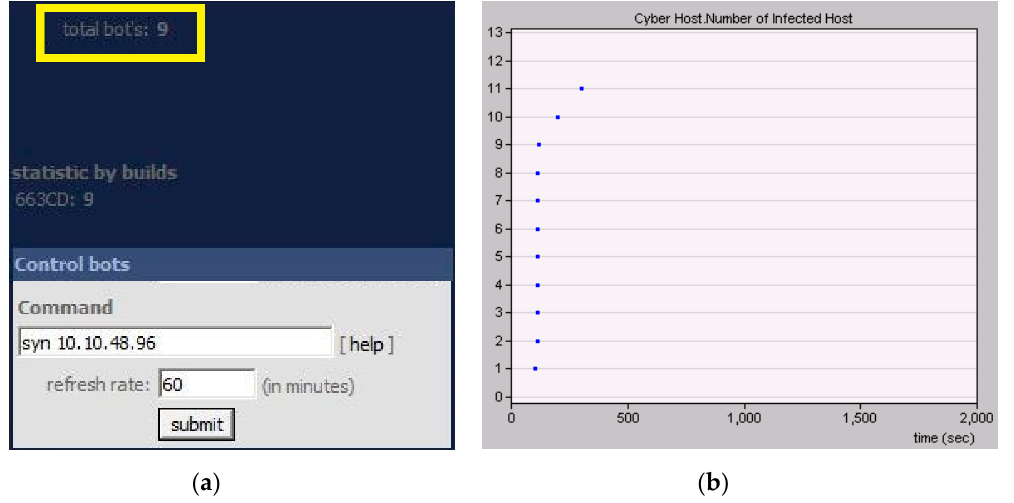
Figure 13. This is numbers of infected hosts: ( a ) total number of bots in real-world network of Figure 11; ( b ) total number of infected hosts in the proposed analysis system of Figure 12.